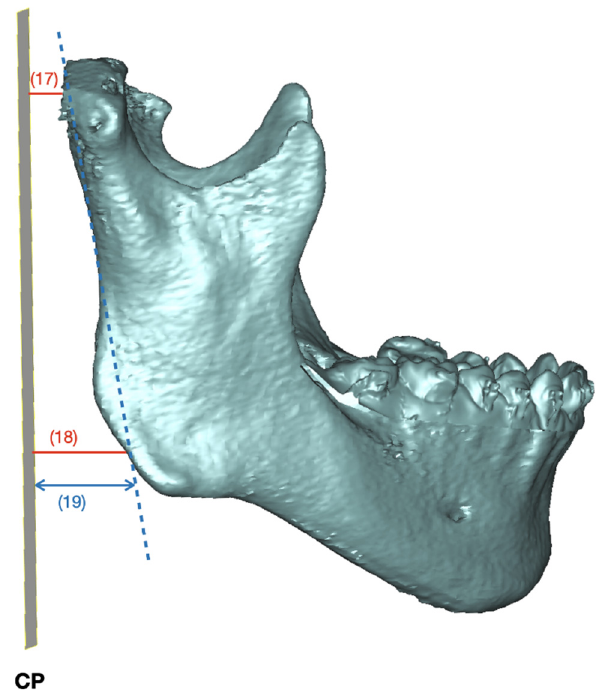
Figure 5. Mandibular measurements in sagittal view. (17) Co to CP, (18) Go to CP, (19) ramus axis to CP.